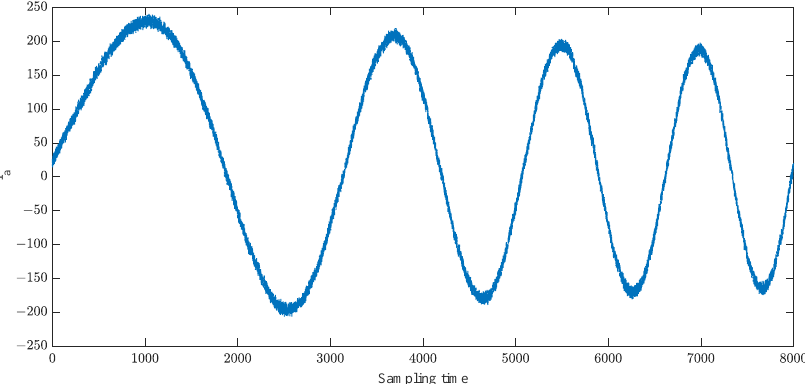
Figure 8. Current signal i a with noise.